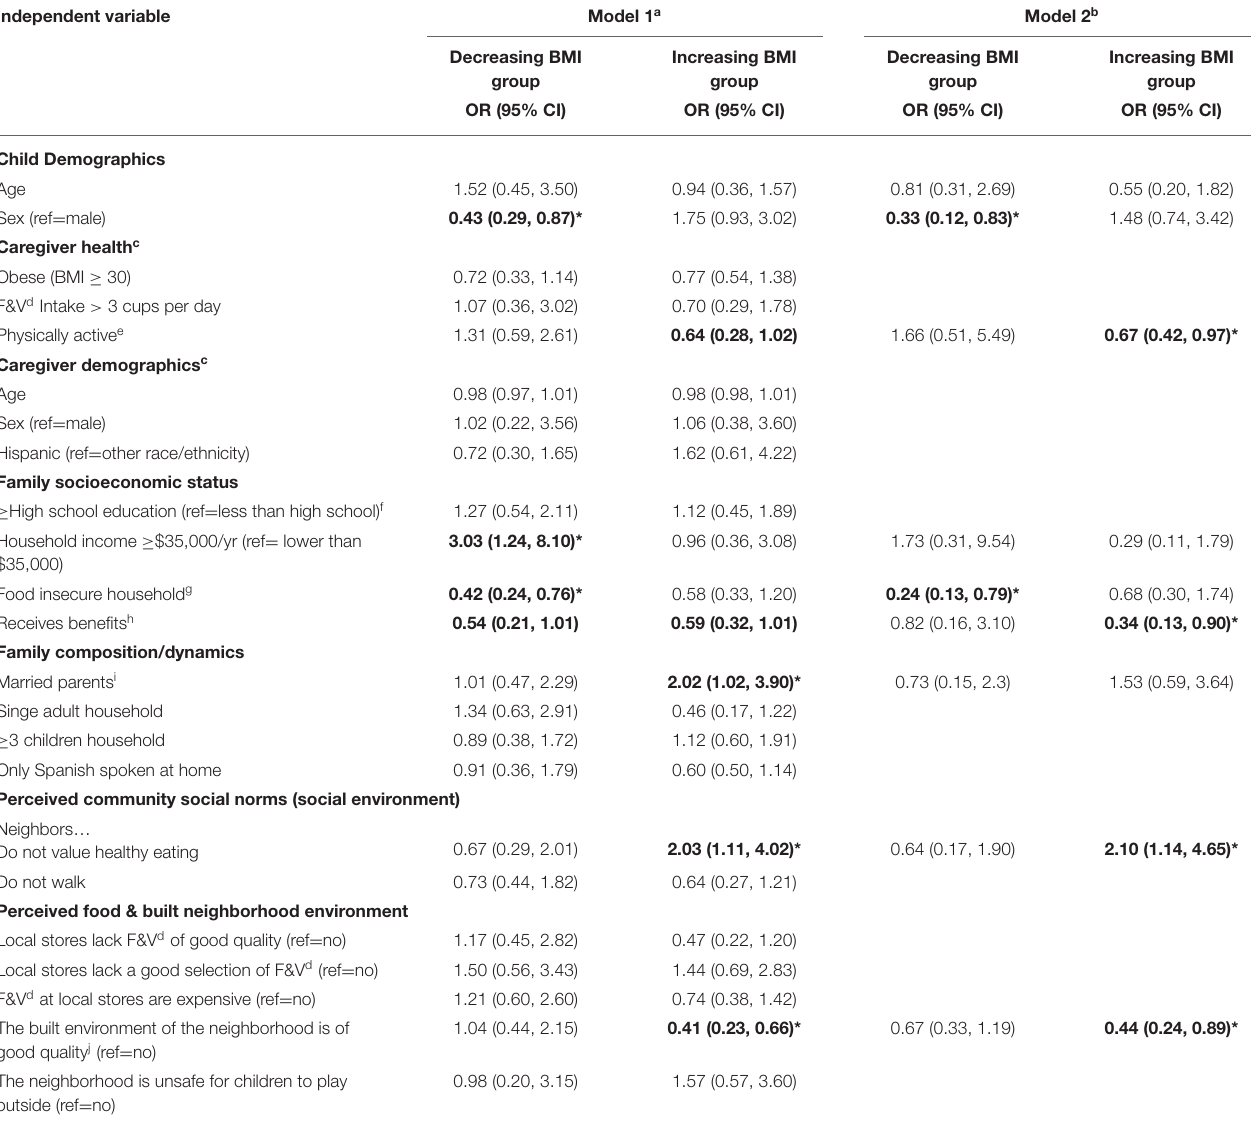
TABLE 3 | Associations between baseline ecological characteristics and child Body Mass Index (BMI) change status from baseline to follow-up (referent is “no change” group); Go Austin! Vamos Austin! cohort (2013–2017; n = 286). Independent